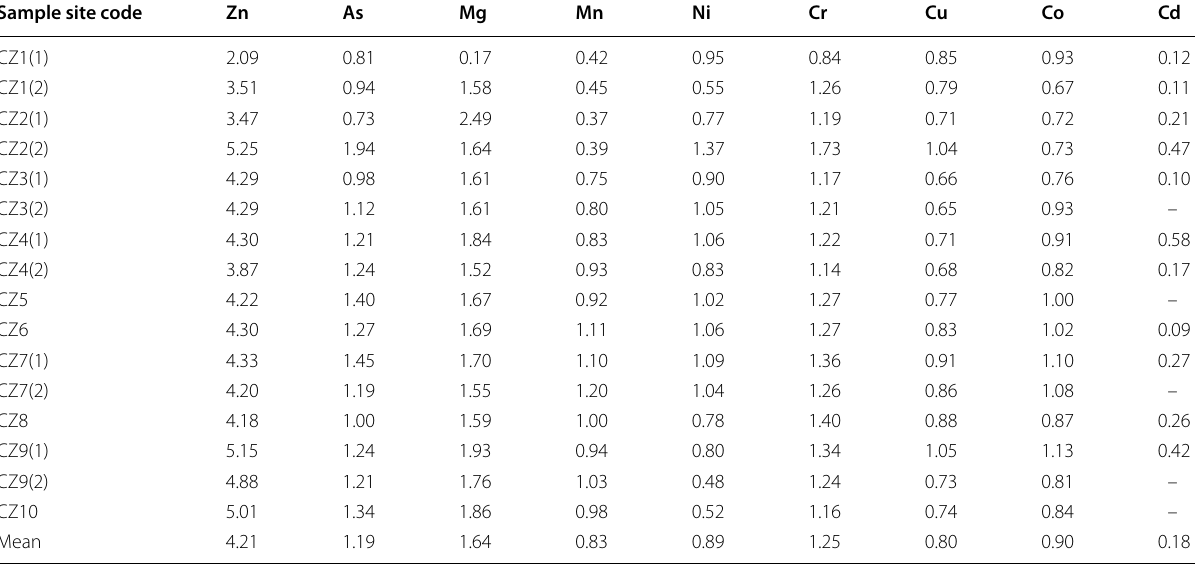
Details of sample site codes are mentioned in the materials and methods section